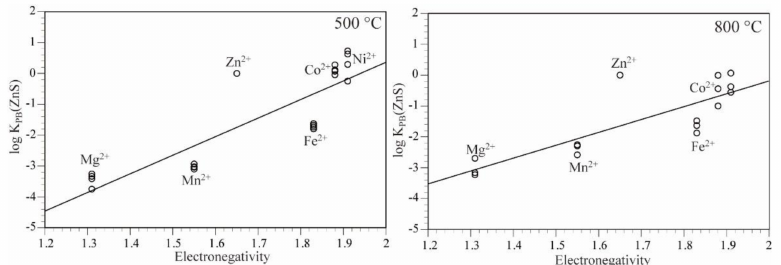
Figure 5. Logarithmic value of bulk partition coefficient (log K PB ) vs. electronegativity diagram for ZnS–(Ni, Mg, Co, Fe, Mn)Cl 2 –H 2 O system. Straight lines obtained using a least-squares method and experimental results for Ni, Mg, Co, Fe, and